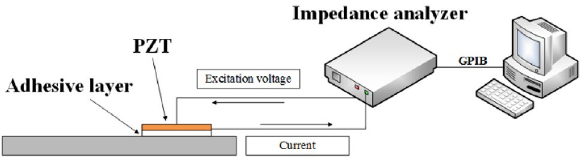
Figure 1. Schematic diagram of plate damage detection experimental devices.